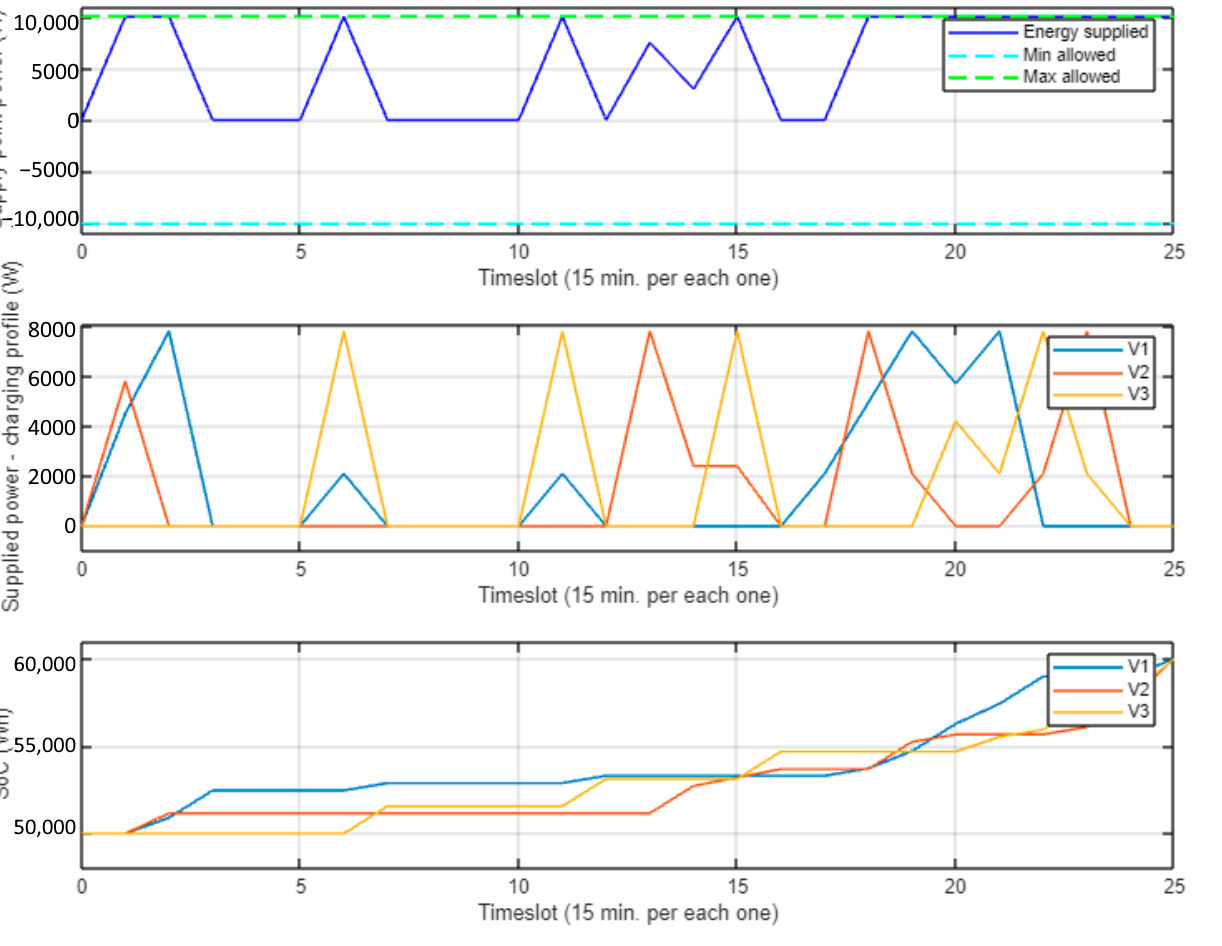
Figure 10. SCT output for a situation without relevant constraints.